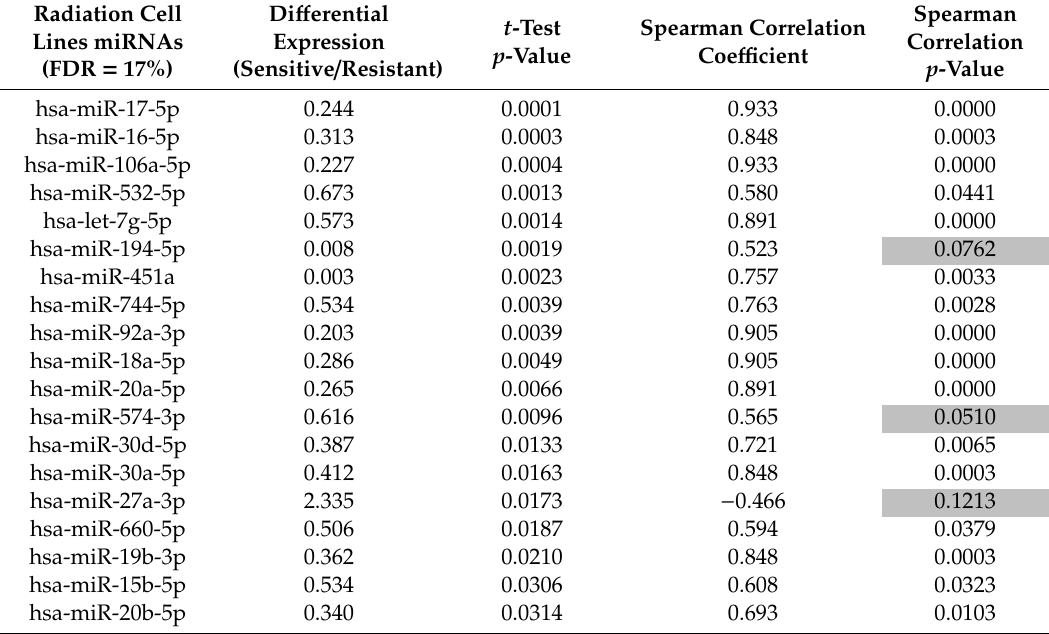
Table 1. miRNAs that were associated with treatment response to radiation in OAC cell lines. Significant treatment response was measured as (i) di ff erential expression (DE) between cell lines that had low vs. high survival fractions, and (ii) non-parametric correlation of expression levels with survival fractions across all cell lines. miRNAs with Spearman correlation p -values > 0.05 are highlighted in